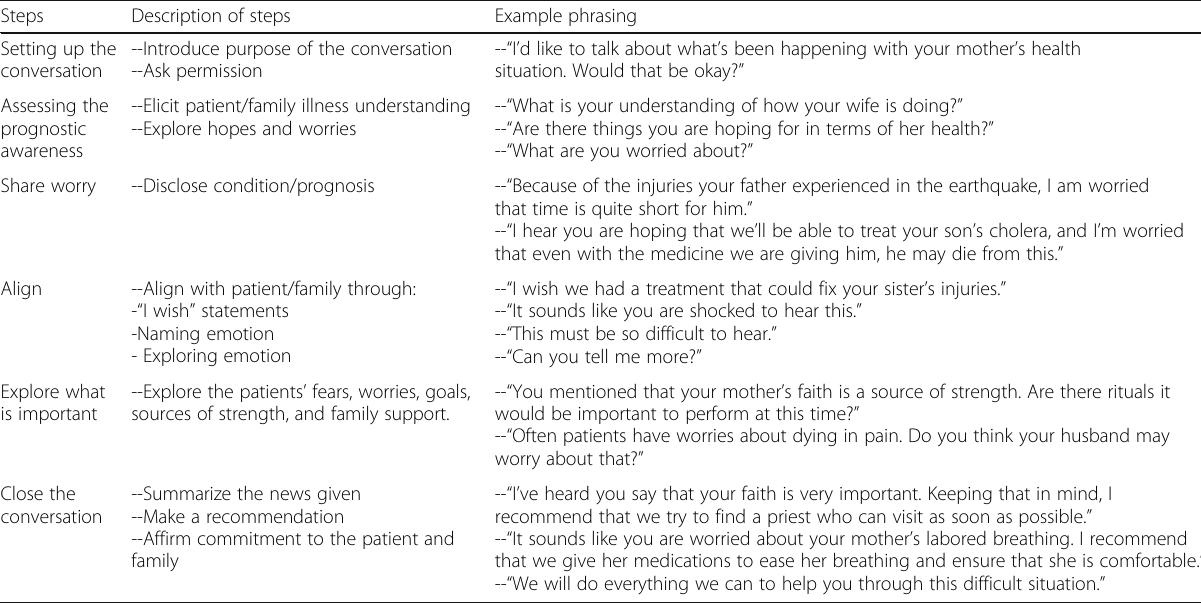
Table 5 Serious Illness Conversation Guide for the disaster medicine